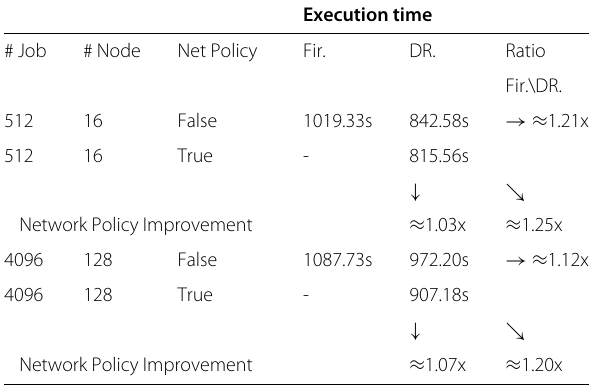
Table 4 Total makespan. Where Fir. is Firmament and DR. is DRMaestro